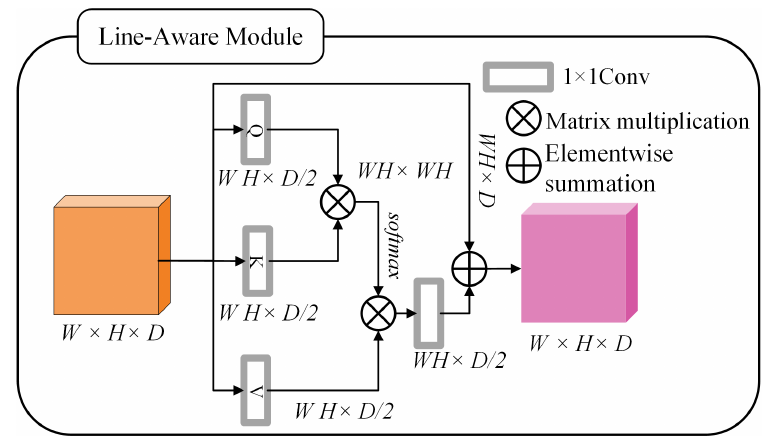
Figure 5. The line-aware